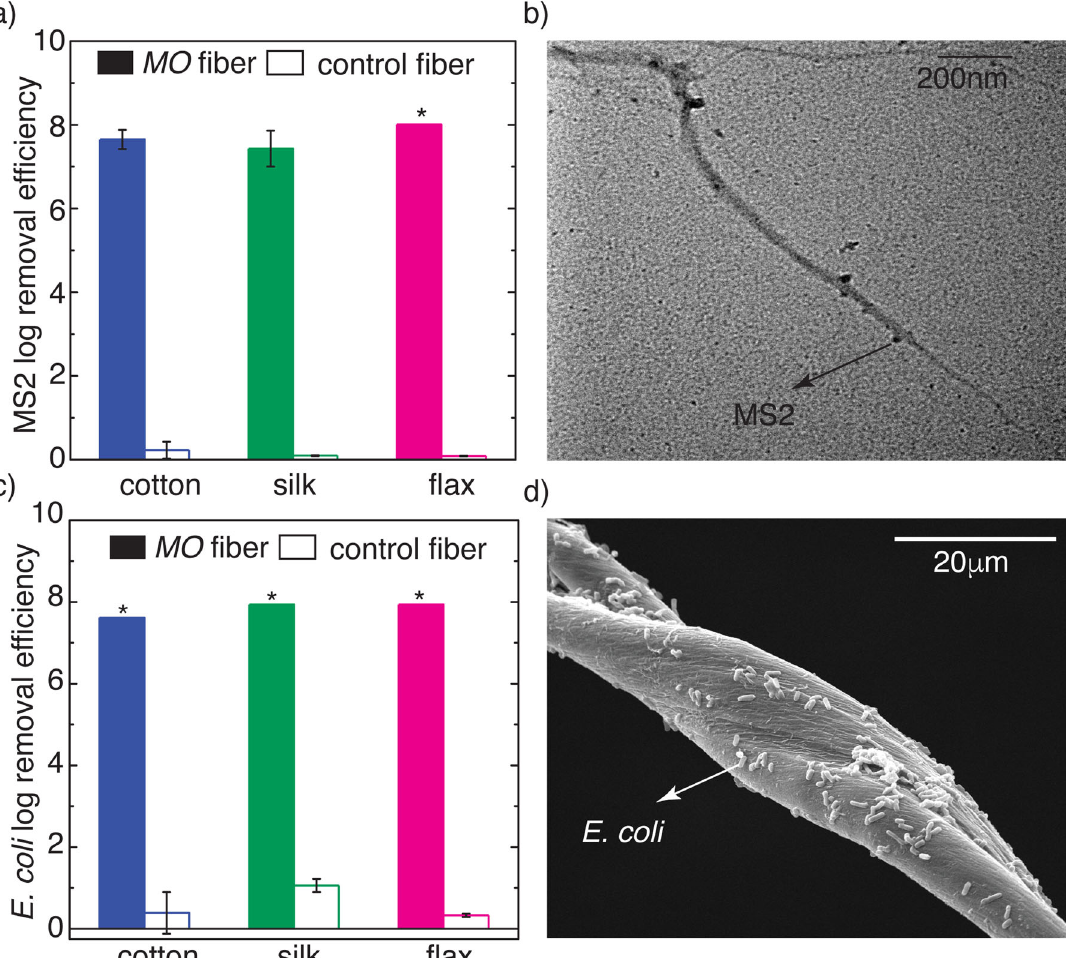
Fig. 4 Moringa oleifera functionalized fi ber fi lters achieve ~7 orders of magnitude higher pathogen removal compared to uncoated fi ber fi lters indicating favorable interaction between MO proteins and bacteria/virus tested is responsible for their removal. a Experimental log 10 removal of 10 8 PFU mL − 1 MS2 in fl uent using MO -functionalized fi ber fi lters compared to that of uncoated fi ber fi lters at a fl owrate of 2 mL min − 1 show MO - fi ber fi lters achieve ~7 orders of magnitude higher than uncoated fi ber fi lters. b Transmission electron microscopy image of MO -cotton samples taken from a fi lter after fi ltering MS2 bacteriophage in fl uent shows that the MS2 bacteriophage has adhered to the surface of MO -coated cotton. c Experimental log 10 removal of 10 8 CFU mL − 1 E. coli in fl uent using MO -functionalized fi ber fi lters